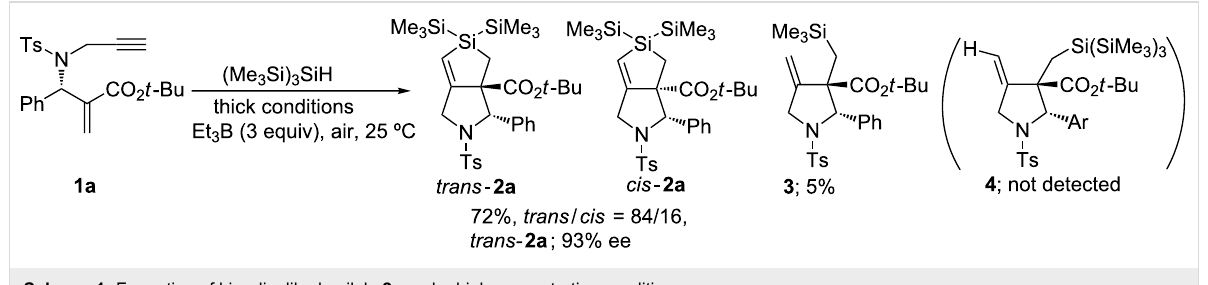
Scheme 1: Formation of bicyclic dihydrosilole 2a under high concentration conditions.